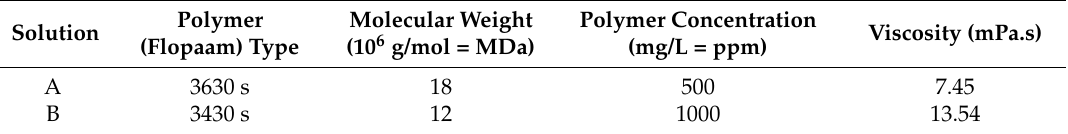
Table 1. Physicochemical properties of